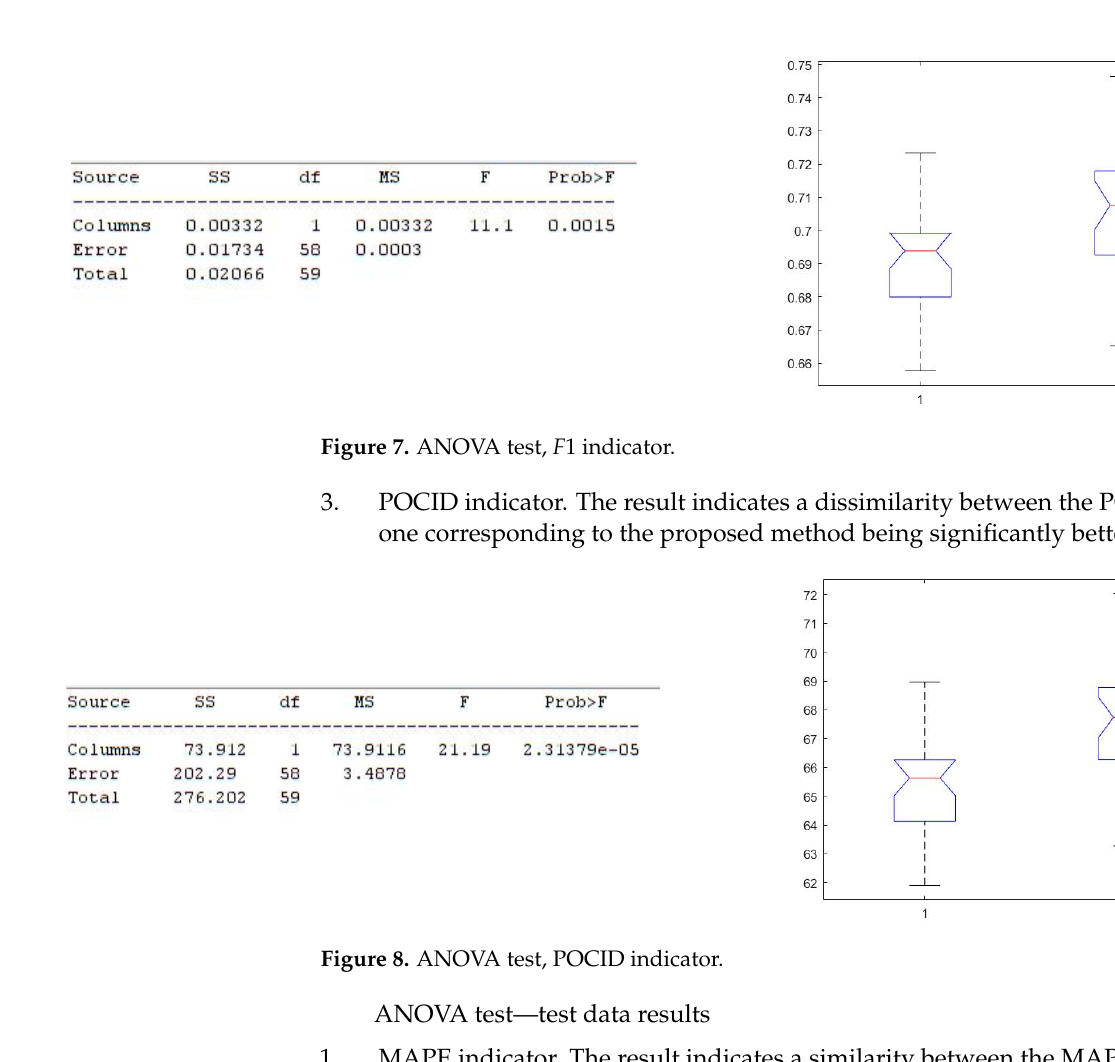
2. F 1 indicator. The result indicates a dissimilarity between the F1 values, the one cor-